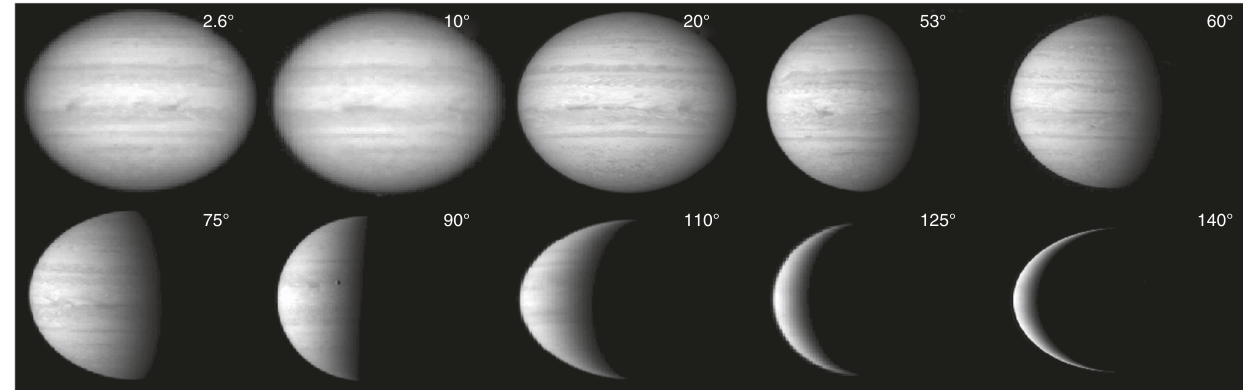
Fig. 1 Examples of Jupiter ’ s global images in the indicated phase angles recorded by the Cassini ISS. The images were recorded by the Cassini ISS at the second continuum fi lter (CB2) during the Jupiter- fl yby mission in 2000 –